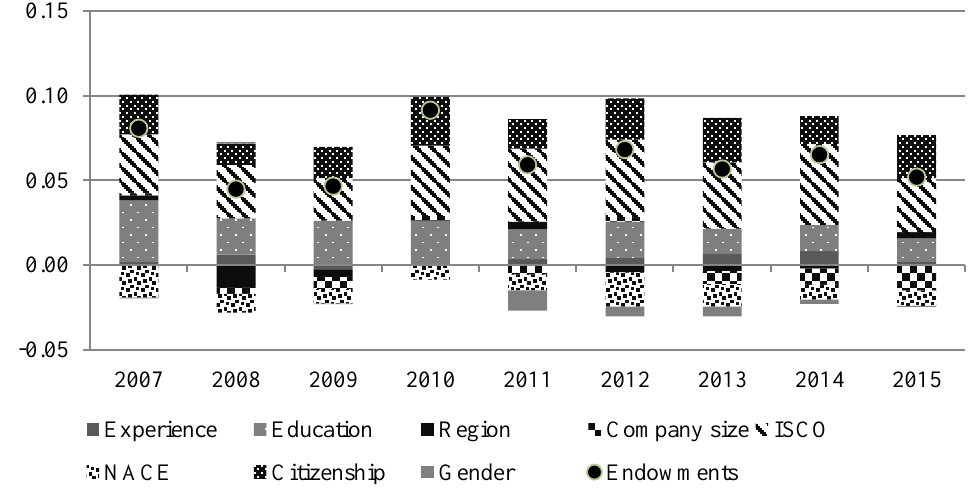
Fig. 2. Breakdown of the endowment effect (ethnic wage gap; log-points;